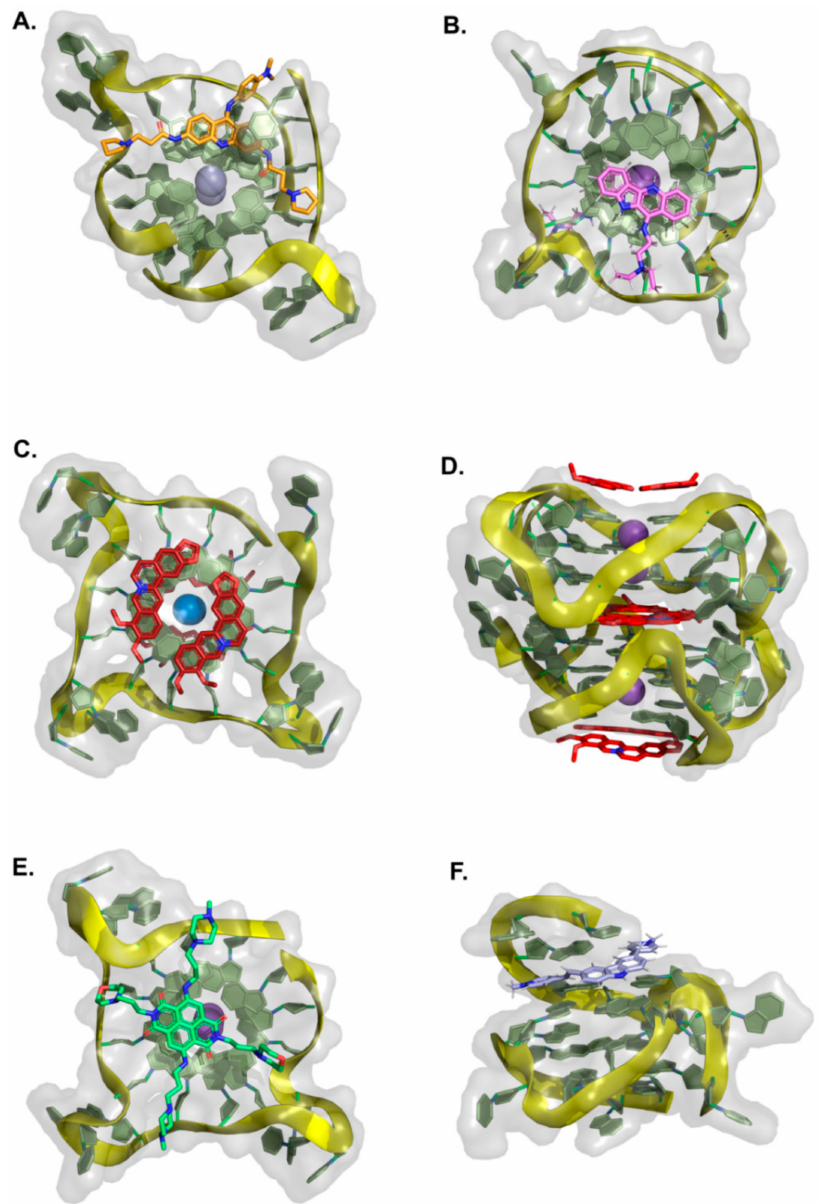
Figure 8. Structural representation of different classes of fused aromatic polycyclic ligands (colored sticks) in complex with different G4s (represented as cartoon and transparent surface). In ( A ) we have represented BRACO-19 in complex with a parallel human telomeric G4 (3CE5); in ( B ) a indolo- quinoline derivative in complex with a c-MYC G4 (2L7V); in ( C , D ) berberines in complex with a human telomeric G4 (3R6R—[206]); in ( E ) the complex of the naphthalene diamine MM41 and human telomeric DNA G4 (3UYH) and in ( F ) the representation of the BMVC carbazole interacting with a parallel c-MYC promoter DNA G4